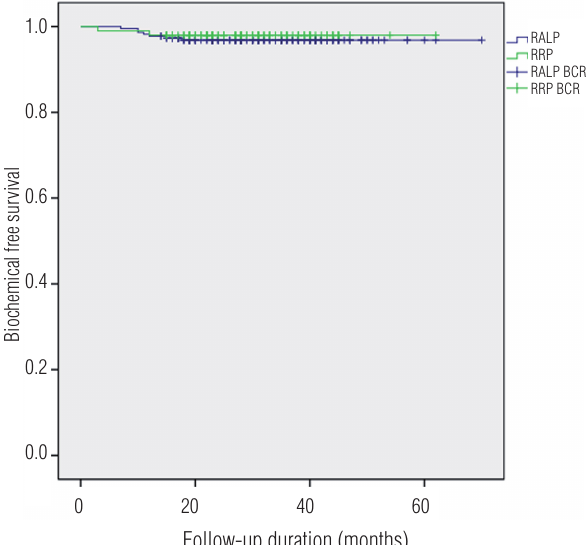
figure 4 - Overall 3-year biochemical recurrence-free survival rates.